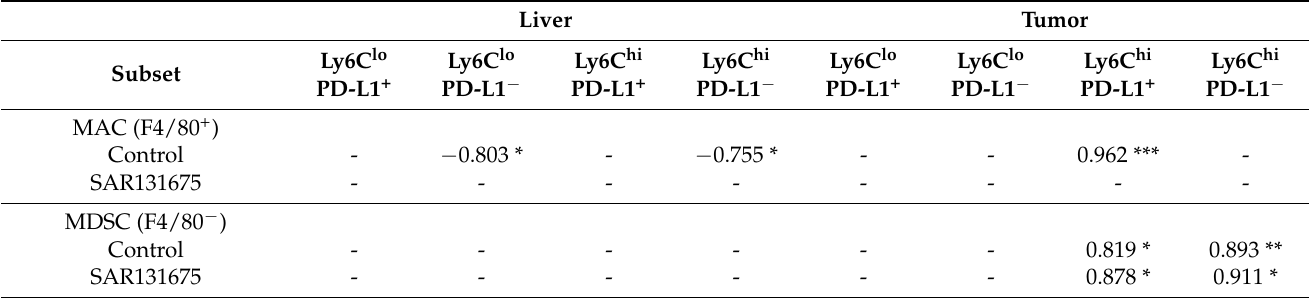
Table 5. Associations for myeloid cell subsets correlations with CD4 + T cell subset a . Liver